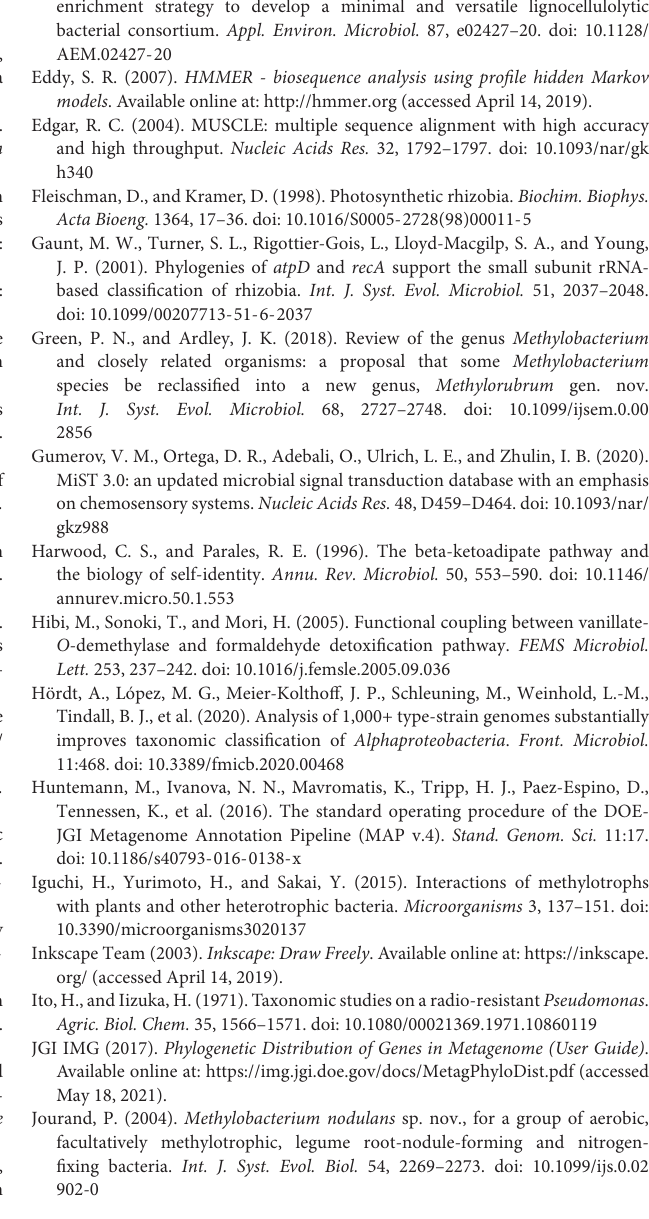
Supplementary Table 10 | Metagenomes in which BLAST hits with 90% similarity to a Methylobacteriaceae query genome were found. Supplementary Table 11 | Summary of results from BLAST search of metagenomes for hits to each query Methylobacteriaceae genome, by sample type. Supplementary Table 12 | Growth of Methylobacterium sp. 4–46 with and without lanthanum, shown in Supplementary Figure 7 . Time, incubation time in hours. OD, optical density at 600 nm. La, with or without lanthanum (25 µ M